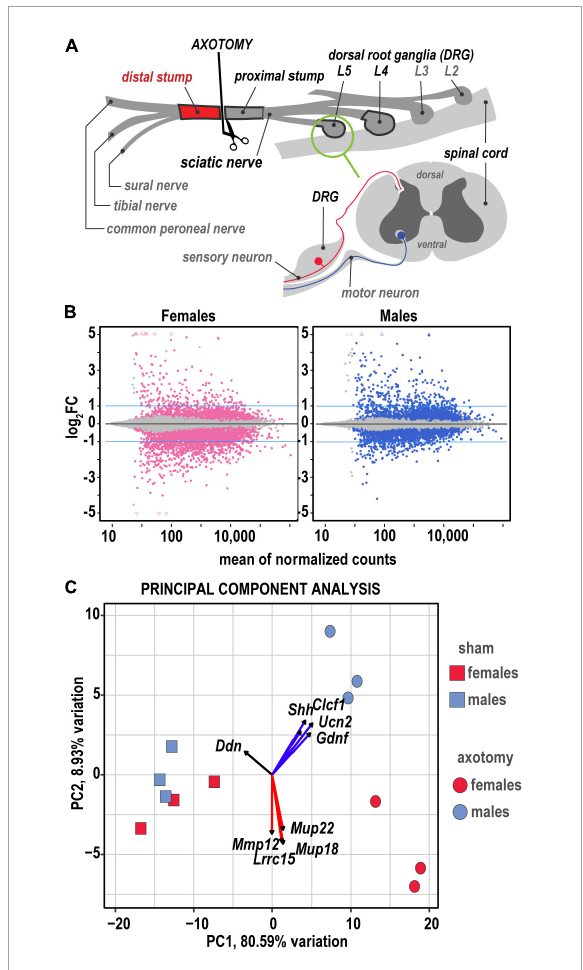
FIGURE1 Global transcriptional profiling in distal nerve 24 h post-axotomy identified sexually dimorphic changes. (A) A schematic of the sciatic nerve axotomy followed by ipsilateral distal stump tissue analysis. RNA-seq of the respective lumbar (L) 4/5 DRG and proximal sciatic nerve stumps from the same animal cohorts were reported earlier (Chernov and Shubayev, 2021, 2022). (B) MA plots display log 2 FC and normalized counts calculated using the default DESeq2 method. The left and right panels show up- and downregulated genes in females (red dots) and males (blue dots), respectively. Colored dots indicate DEGs with P adj < 0.1. Blue lines correspond to log 2 FC thresholds above 1 or below –1. (C) Principal component analysis of female (red) and male (blue) groups of sham (rectangles) and axotomy (circles) samples ( n = 3 samples/group). Red and blue arrows indicate genes with the most influence on variance in females and males,